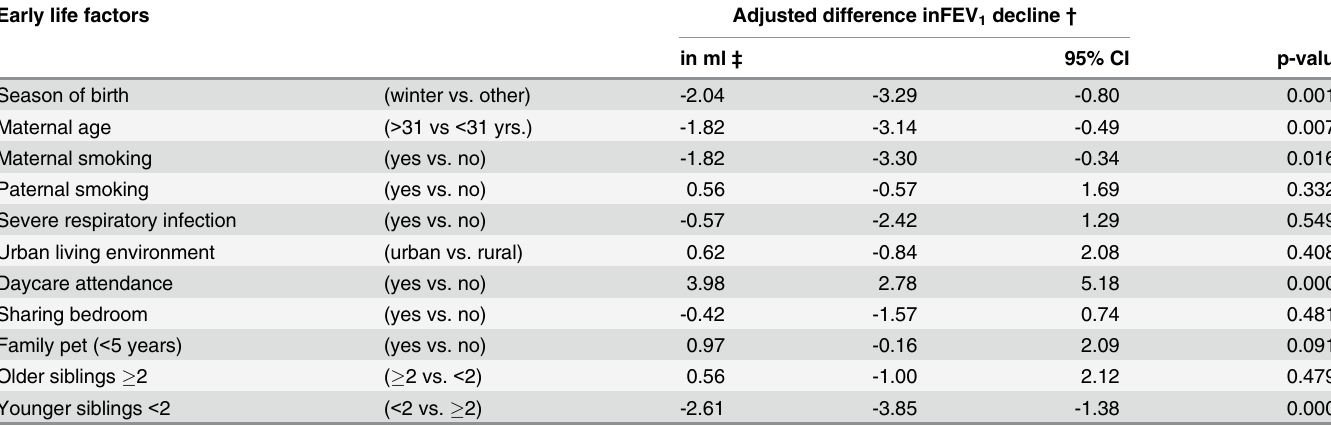
Table 3. The associations of early life factors with lung function decline (mutually adjusted